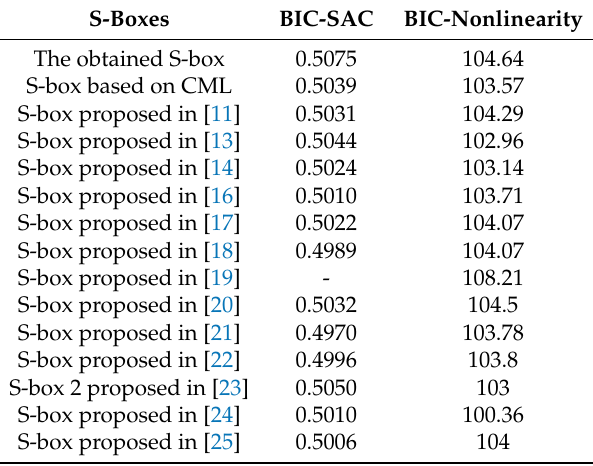
Table 8. The BIC analysis of different